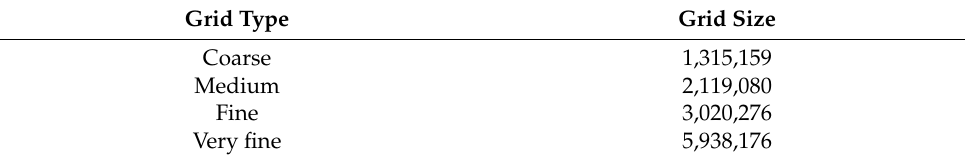
Table 3. Grid size for grid dependency test.